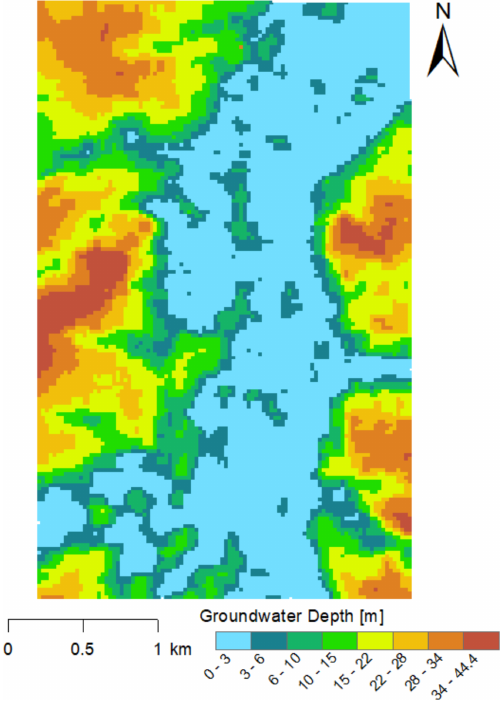
Figure 8. Groundwater depth distribution after steady-state ground- water model calibration.